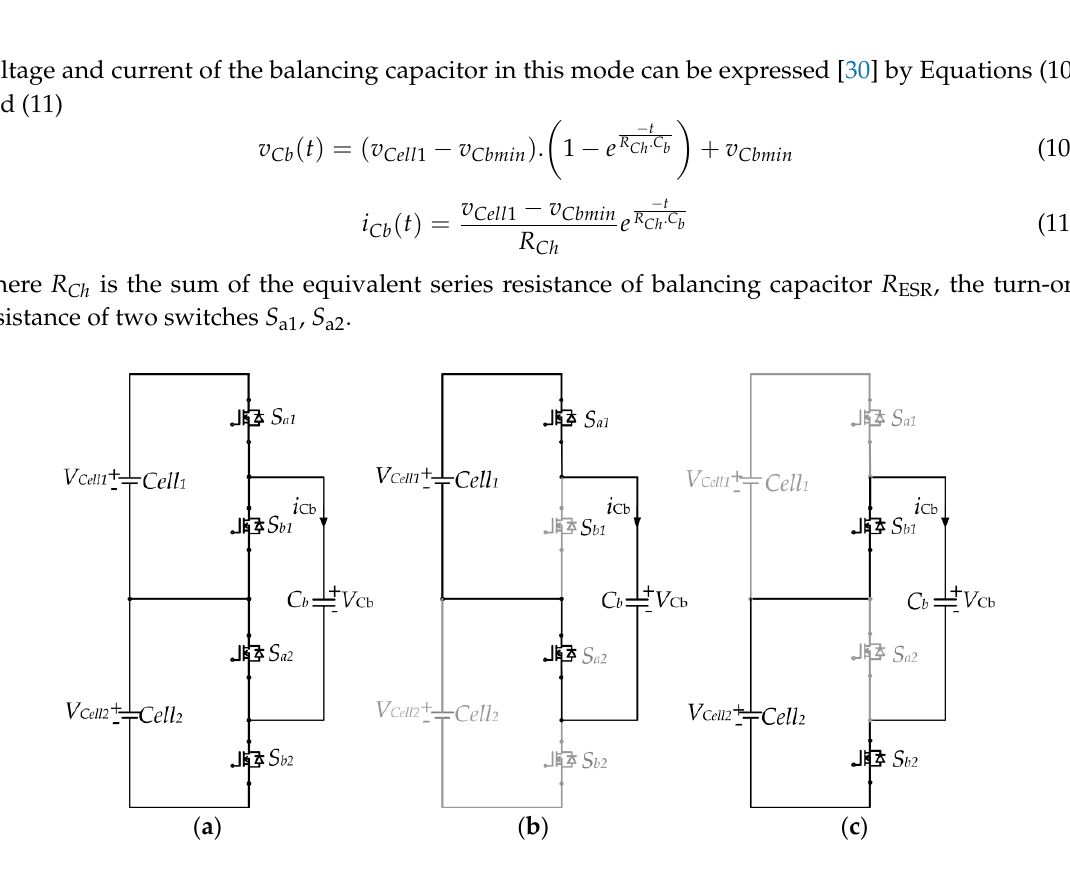
Figure 5. The switched capacitor circuit for two cells [21]: ( a ) Circuit description; ( b ) Mode 1; ( c ) Mode 2.